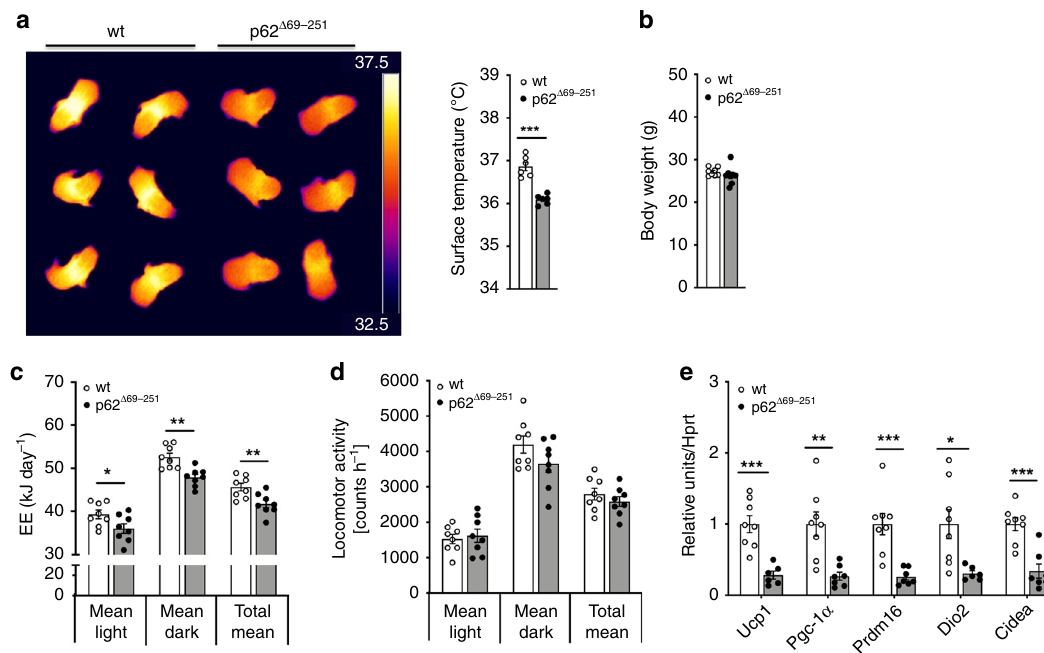
Fig. 3 Impaired energy expenditure and BAT thermogenesis in lean p62 Δ 69-251 mice. Infrared thermographic imaging and surface temperature of 7-d-old male wt or p62 Δ 69-251 mice ( a ). Body weight ( b ), energy expenditure ( c ), and locomotor activity ( d ) of lean, non-obese 12-wk-old male mice fed with a regular chow diet. Gene expression of thermogenic markers in BAT of lean non-obese 12-wk-old male mice ( e ). Sample sizes are ( a ) n = 6/6 mice, ( b – d ) n = 8/8 mice, ( e ) Ucp1 n = 8/6 mice, Pgc-1 α n = 8/7 mice, Prdm16 n = 8/7 mice, Dio2 n = 8/6 mice, Cidea n = 8/7 mice. Data represent mean ± SEM. Bar graphs were analyzed using two-sided two-tailed t -test. * p < 0.05; ** p < 0.01; *** p < 0.001. Exact p -values are ( a ) p = 0.000037; ( b ) p = 0.327; ( c ) mean light p = 0.0425, mean dark p = 0.00128, mean total p = 0.0068; ( d ) mean light p = 0.691 mean dark p = 0.135, mean total p = 0.352; ( e ) Ucp1 p = 0.000383, Pgc1a p = 000217, Prdm16 p = 0.00064, Dio2 p = 0.0141, Cidea p =